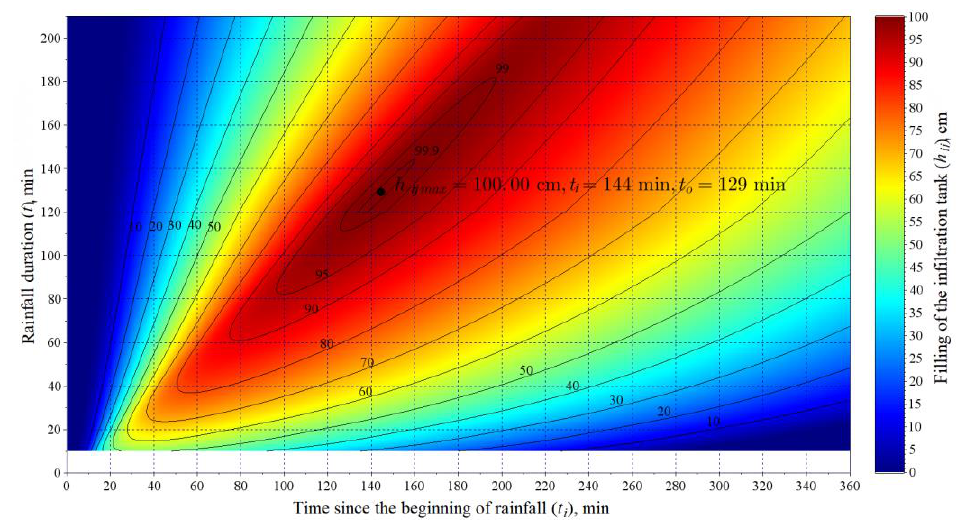
Figure 5. Infiltration tank fill level ( h ij ) in time ( t i ) depending on the duration of the rainfall ( t ), determined for its bottom area of S i = 563.30 m 2 ( h ijmax —maximum fill level in the tank at a given area of its bottom; t o — critical rainfall duration).